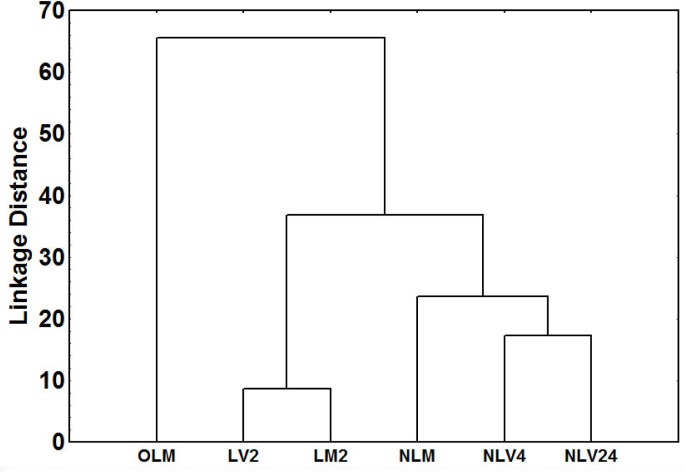
Dendrogram of chemical distances among different groups of invasive queens (Euclidean distances, Ward’s method).The abbreviations are as follows: older, field-collected queens (OLM) (n = 17), two-week-old laying mated queens (LM2) (n = 10), two-week-old laying virgin queens (LV2) (n = 9), non-laying mated queens (NLM) (n = 12), 4-day-old non-laying virgin queens (NLV4) (n = 15), and 24-hour-old non-laying virgin queens (NLV24) (n = 13).